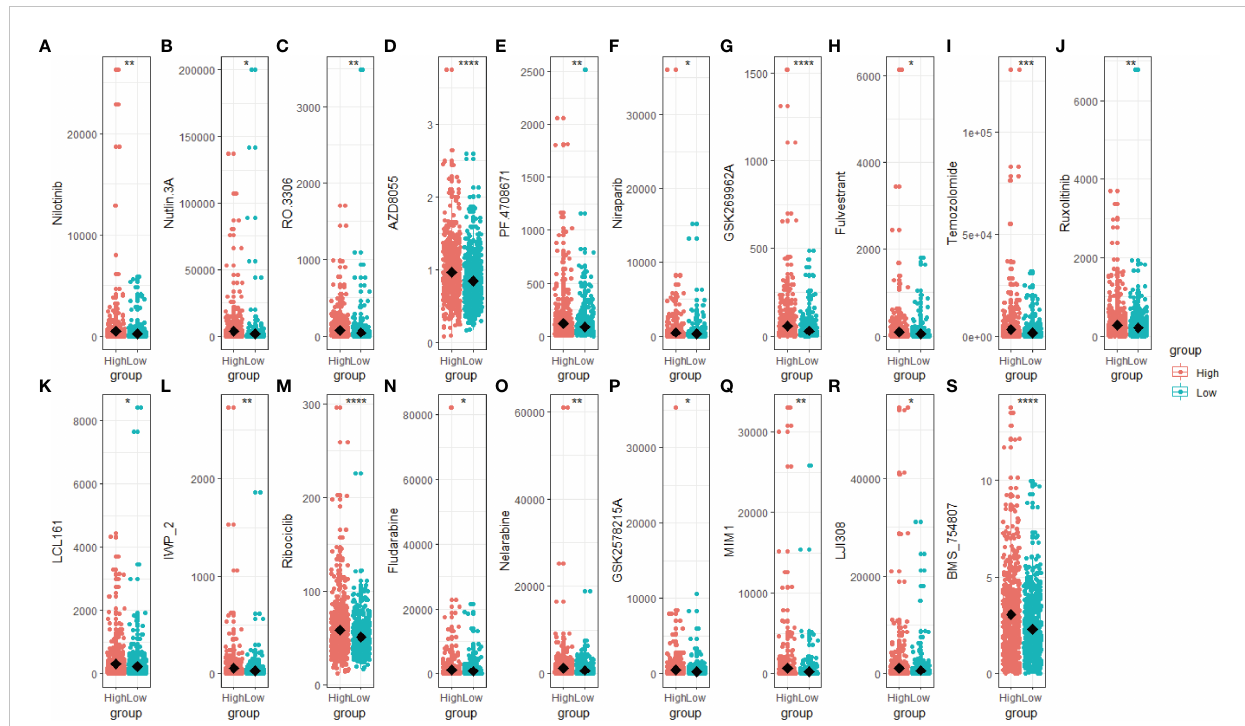
FIGURE 7 Drug sensitivity score of the high- and low-scoring groups. Box plot of the drug sensitivity score of Nilotinib (A) , Nutlin 3A (B) , RO 3306 (C) , AZD8055 (D) , PF4708671 (E) , Niraparib (F) , GSK269962A (G) , Fulvestrant (H) , Temozolomide (I) , Ruxolitinib (J) , LCL161 (K) , IWP_2 (L) , Ribociclib (M) , Fludarabine (N) , Nelarabine (O) , GSK2578215A (P) , MIM1 (Q) , LJI308 (R) and BMS_754807 (S) . The drug sensitivity score was predicted based on the R package “ oncoPredict ” , with a lower score representing a better clinical response. ( *p < 0.05; **p < 0.01; ***p < 0.001, ****p< 0.0001